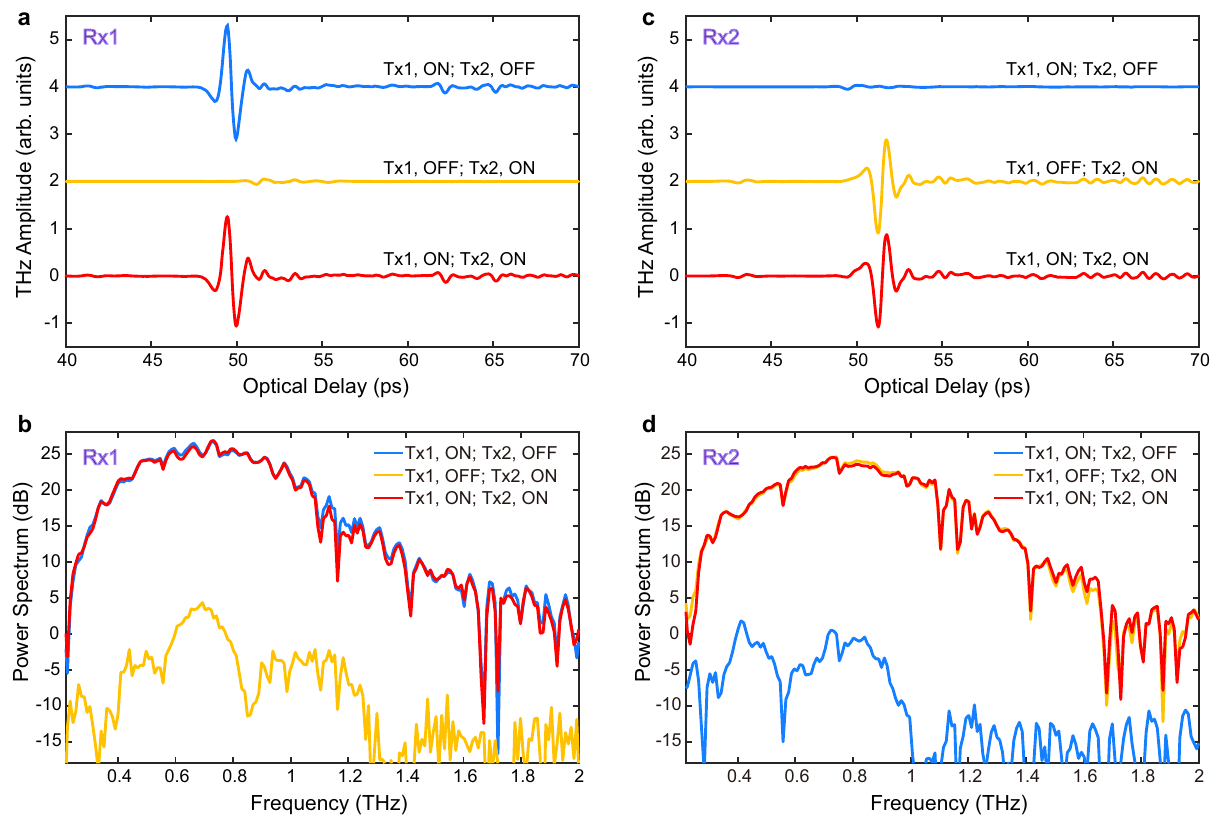
Fig. 4 Experimental demonstration of the independent propagation of two polarization-division multiplexed broadband THz pulses within the four- wire waveguide (FWWG). Time-domain signals ( a ) and corresponding spectra ( b ) reconstructed via Rx1 under different ON/OFF con fi gurations of Tx1 and Tx2. Time-domain signals ( c ) and corresponding spectra ( d ) reconstructed via Rx2 under different ON/OFF con fi gurations of Tx1 and Tx2. The THz time-domain waveforms in ( a ) and ( c ) are vertically shifted for